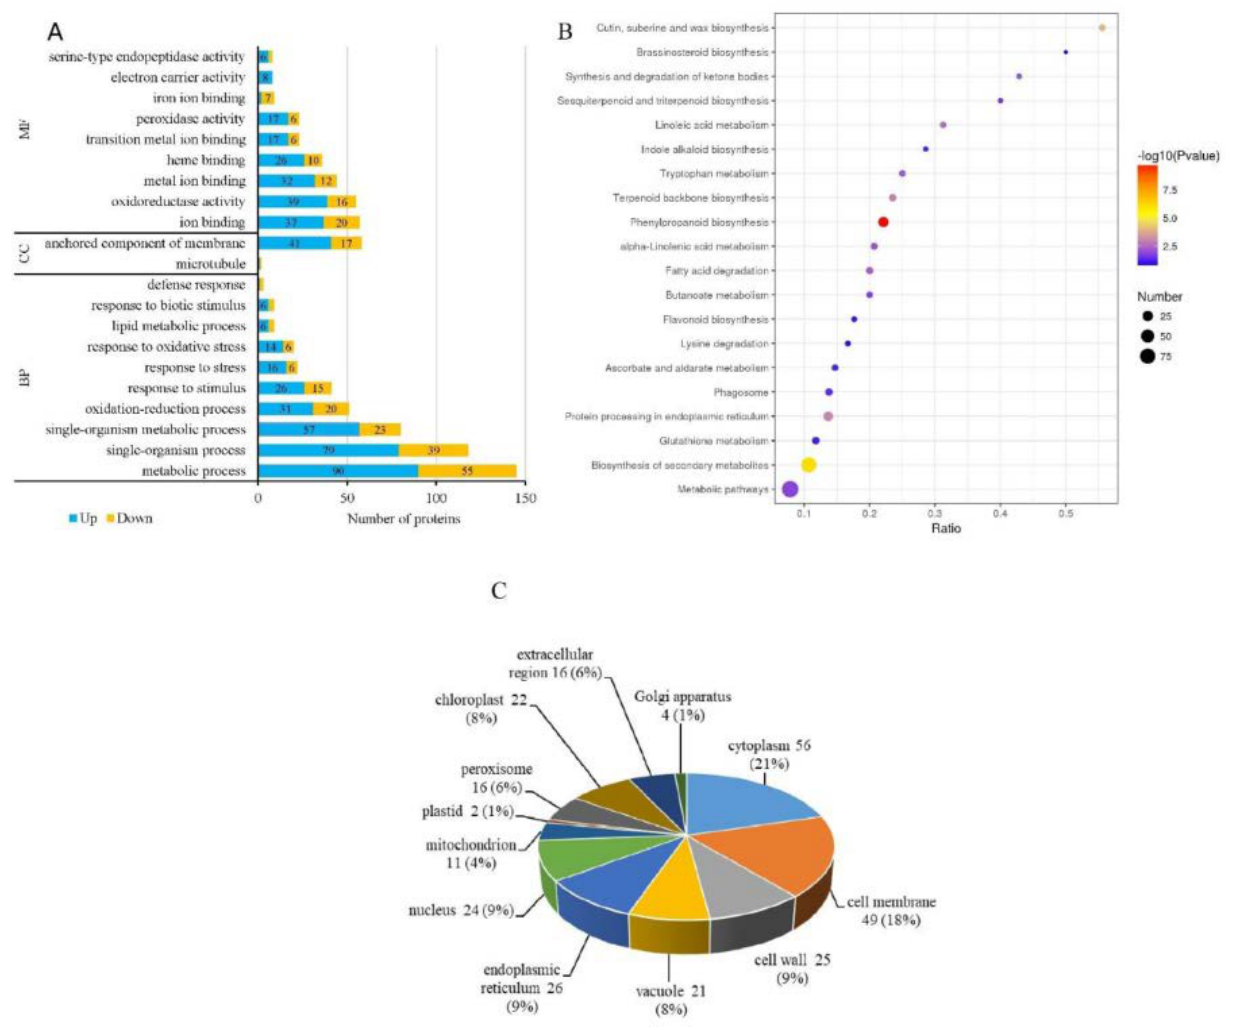
Figure 7. GO enrichment analysis ( A ) and KEGG enrichment analysis ( B ) and subcellular localizations ( C ) of DAPs in tomato roots under ebb-and-flow